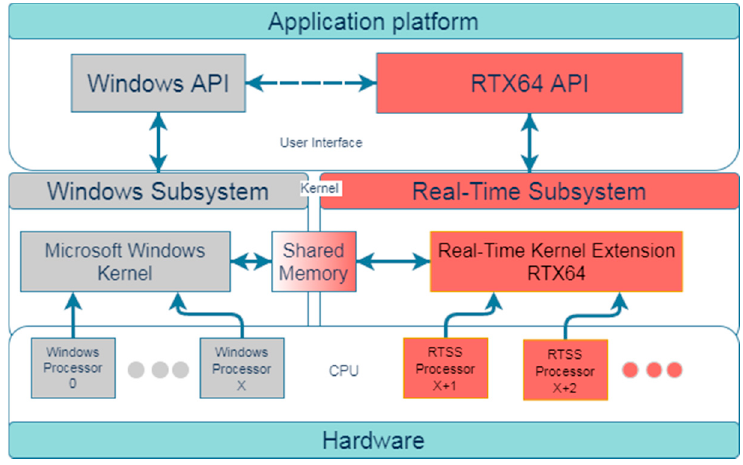
Figure 4. Interval Zero RTX64 subsystem general diagram. A more precise diagram is provided on the Interval Zero website [21]. the Interval Zero website